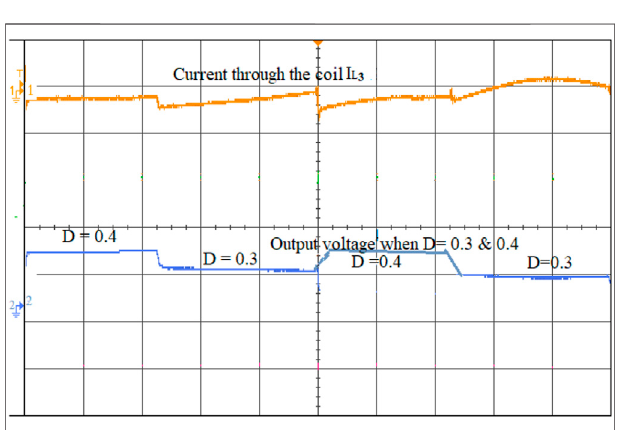
FIGURE 18 | Current through I LC2 and V out at D = 0.3 and 0.4.